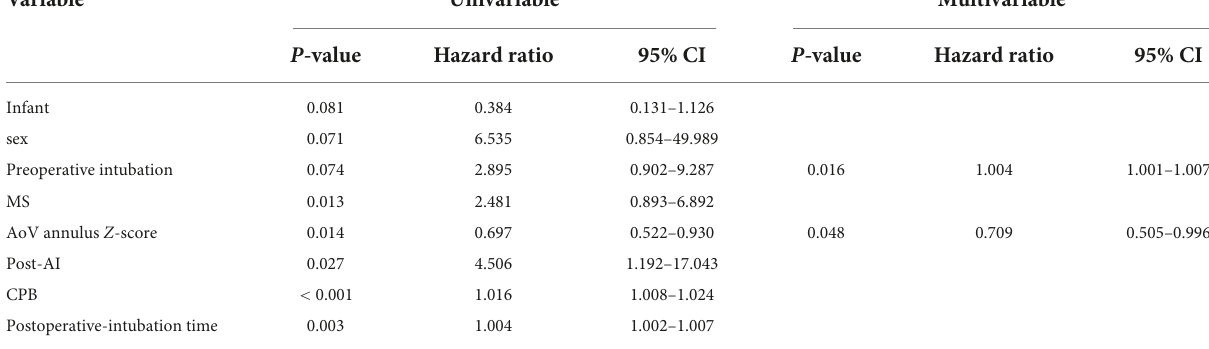
TABLE 5 Univariate and multivariate analyses for adverse